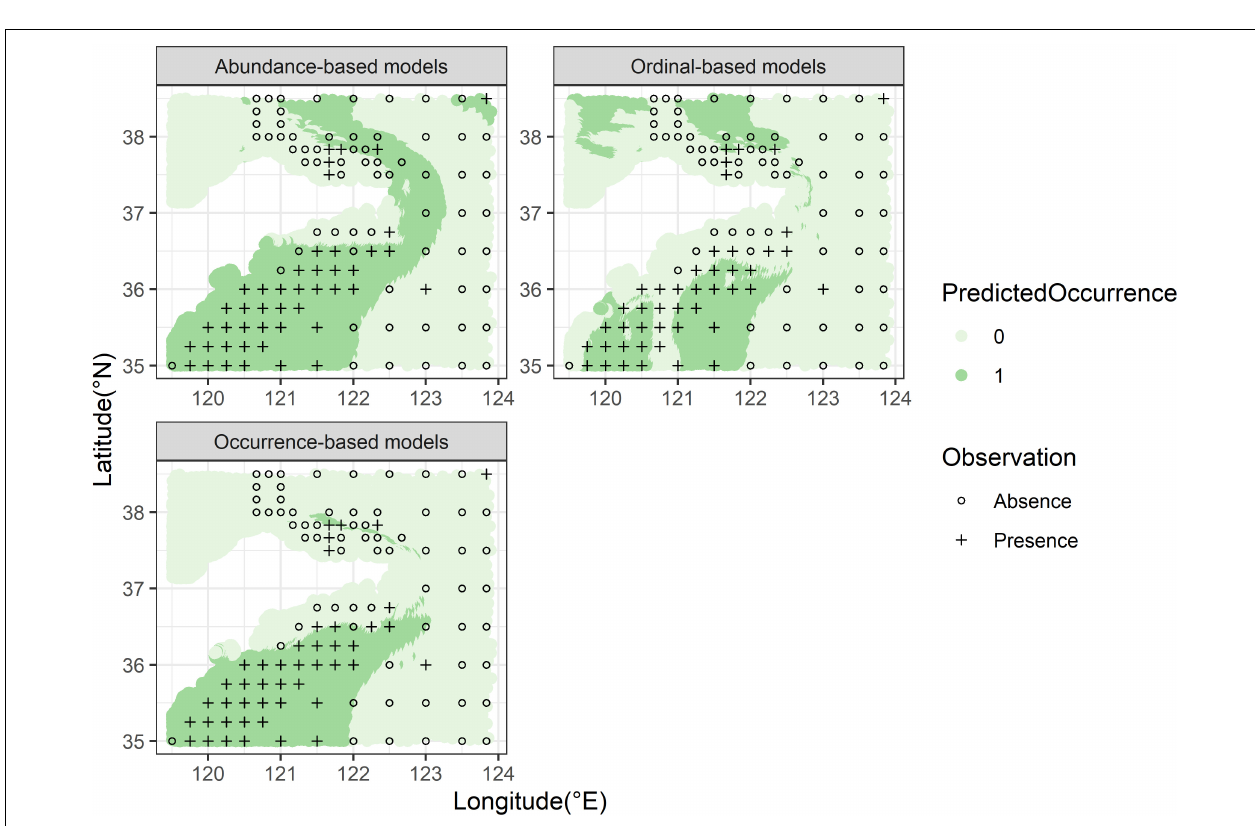
FIGURE 7 | The predicted (color circles) abundance grades of M. dalei by RF for uses of two species data types in the coastal waters of Shandong